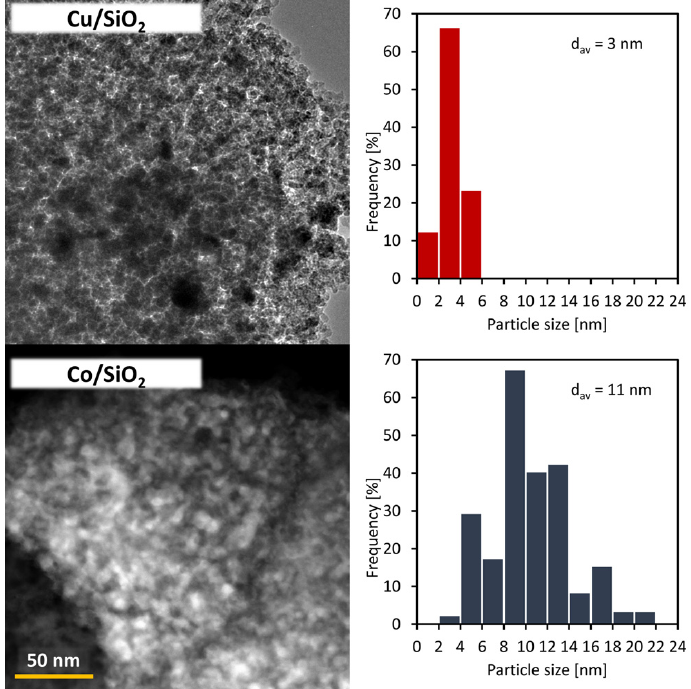
Figure 3. TEM images and particle size distribution of Cu/SiO 2 and Co/SiO 2 .